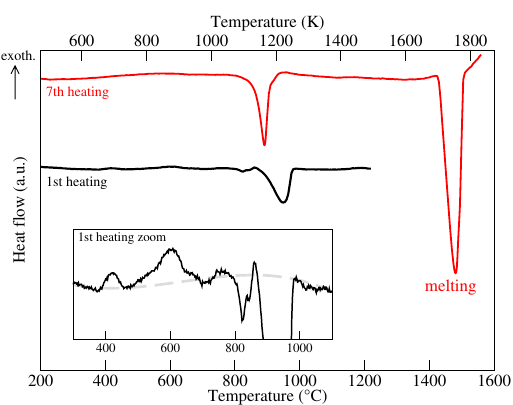
Figure 7. DTA heat flow curves of the Al 15 Hf 25 Sc 10 Ti 25 Zr 25 at.% HEA. The black curve corresponds to the 1 st heating cycle directly after casting. The red curve shows the 7 th heating cycle which corresponds to the equilibrated situation, i.e., further heating cycles show the same dependence. The inset enlarges the 1 st heating curve and the gray dashed line is a guide to the eye indicating the baseline.